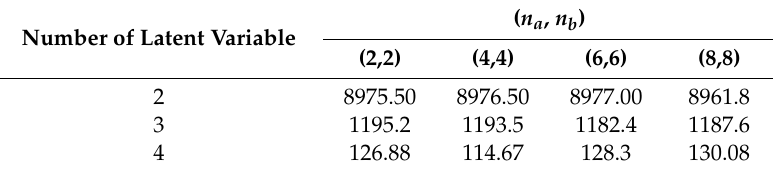
Table 3. The indicator φ for different latent variables and lagged parameters of ARX in dynamic PLS.